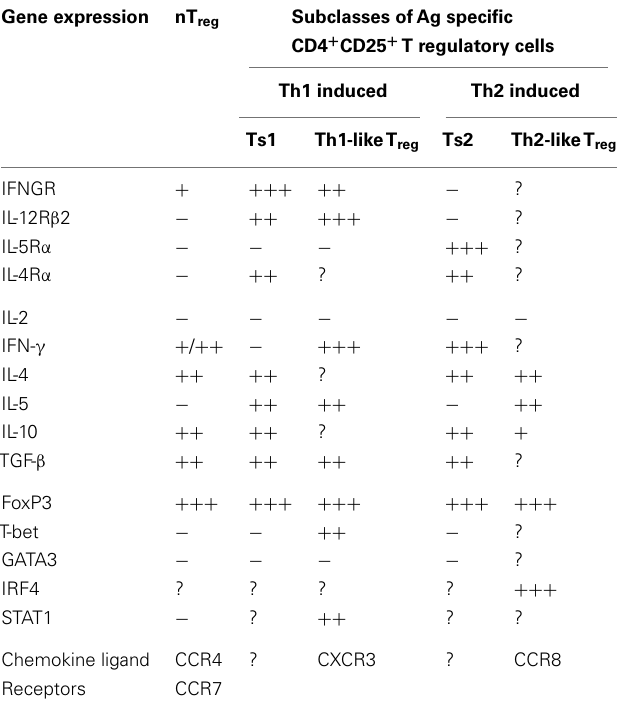
Table 2 | Summarizes the differences inTh1 andTh2 activatedAg specificT reg and nT reg